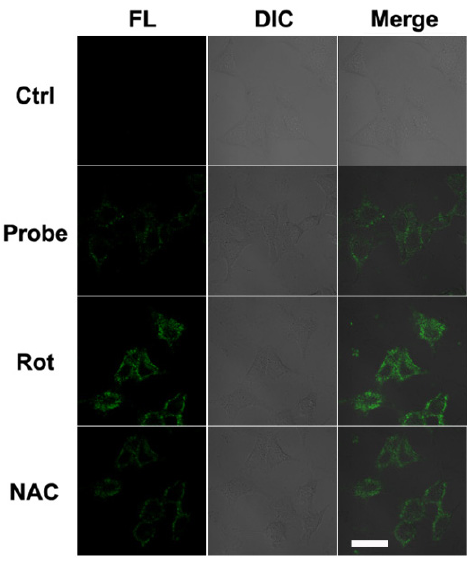
Fig. 4. Confocal images of HeLa cells incubated with CBH for 30 min with pretreatment of Rot and NAC. Scale bar repre- sents 20 (cid:1) m.